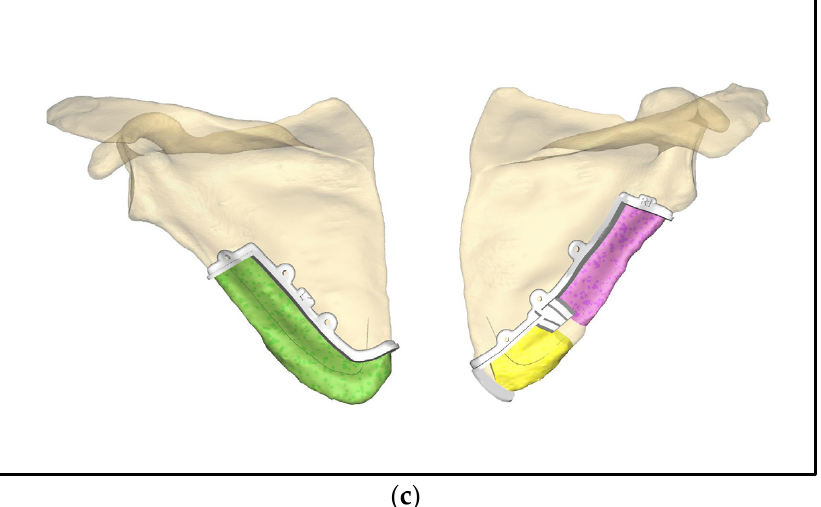
Figure 3. CAD/CAM-guided planning of partial mandibular resection and primary bony reconstruction using free scapular flaps from both sides: ( a ) resected mandible indicated in red; ( b ) reconstructed mandible using three segments from the right (yellow and purple) and left scapula (green), patient-specific plate with an artificial joint on the right side indicated in blue, red arrows indicate the screw positions; ( c ) posterior view on the bone harvested from the left scapula (green, 1 segment) and the right scapula (yellow and purple, 2 segments) with surgical guides.